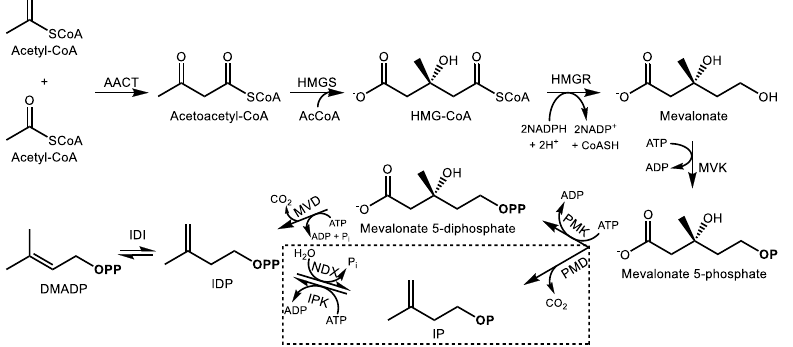
Figure 1. Biosynthesis of isopentenyl (IDP) and dimethylallyl diphosphate (DMADP) via the mevalonic acid (MVA) pathway and alternative MVA pathway (boxed) in the cytosol. Enzyme abbreviations